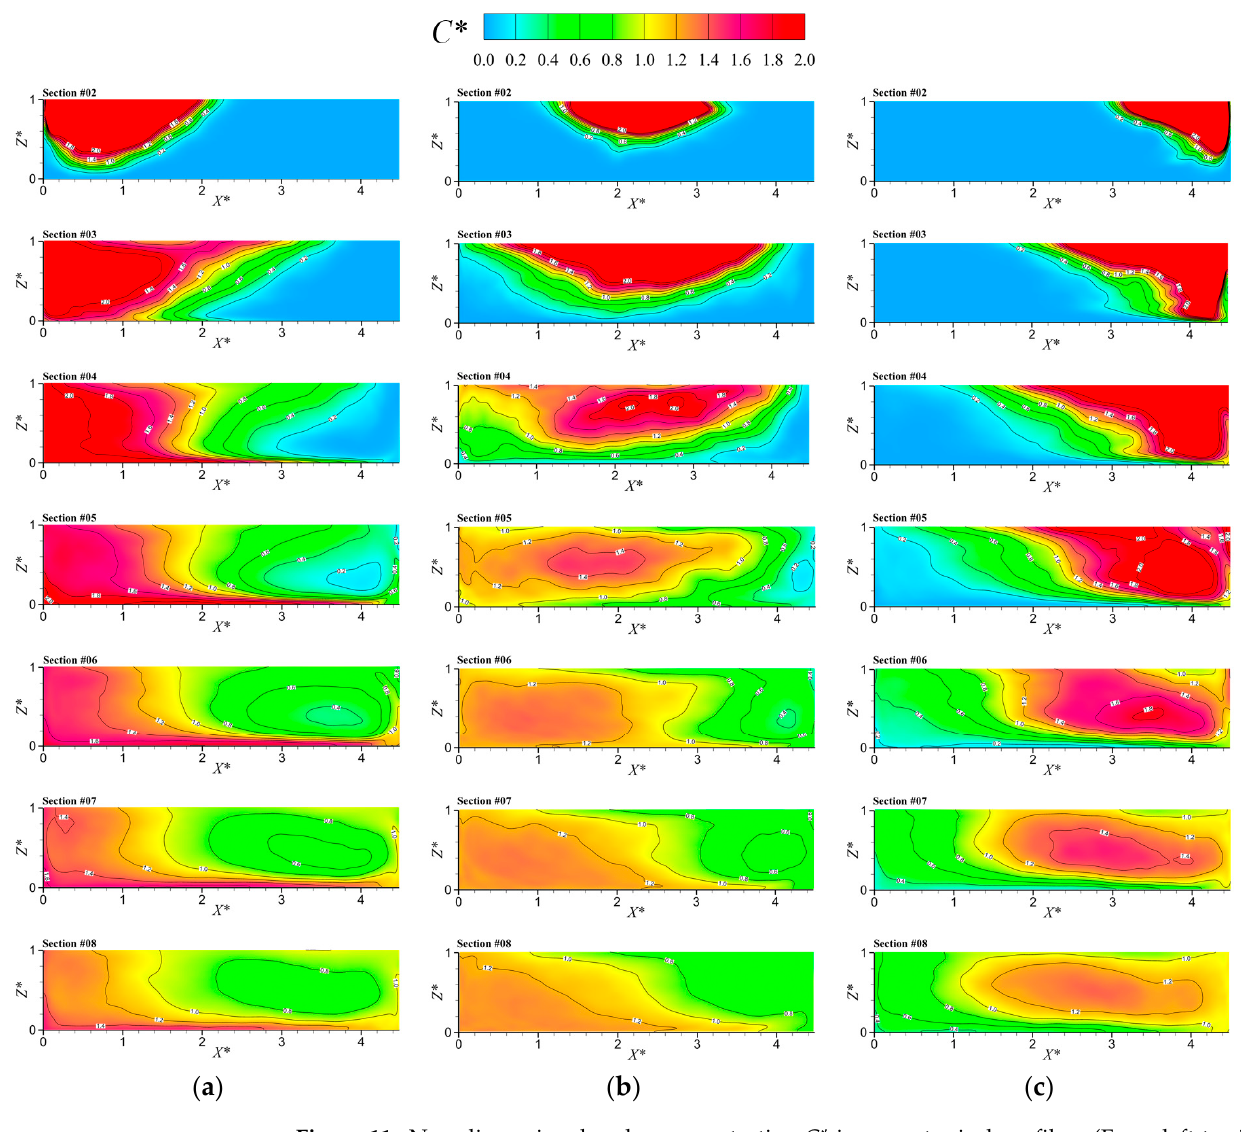
Figure 11. Non-dimensional scalar concentration C* in some typical profiles. (From left to right denotes from inner bank to outer bank). ( a ) Case S1; ( b ) Case S3; ( c ) and Case S5.